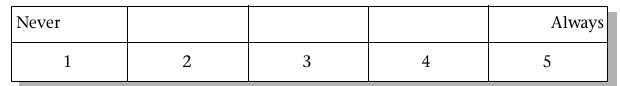
Figure 4 : Suggested response scale to be used in an employment equity